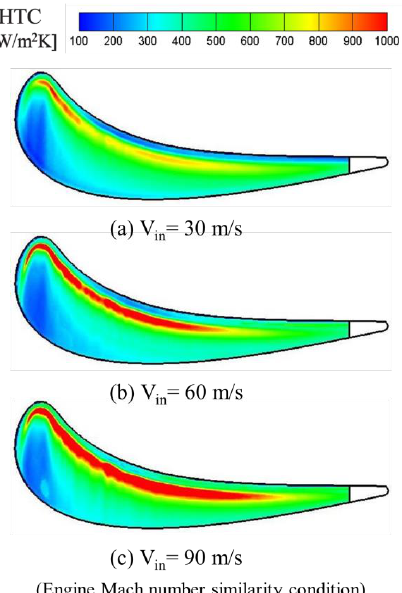
Figure 7. HTC contours of the plane tip.